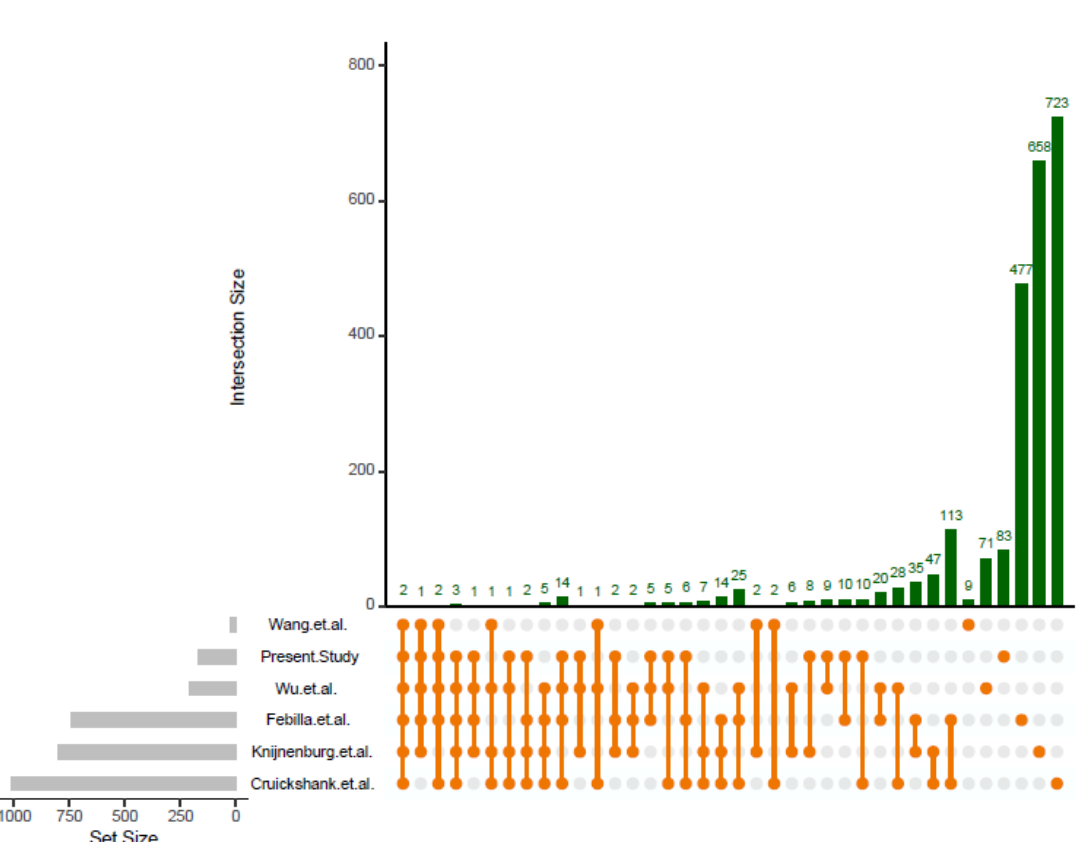
Figure 4. The upset plot showing the degree of consistence among studies.